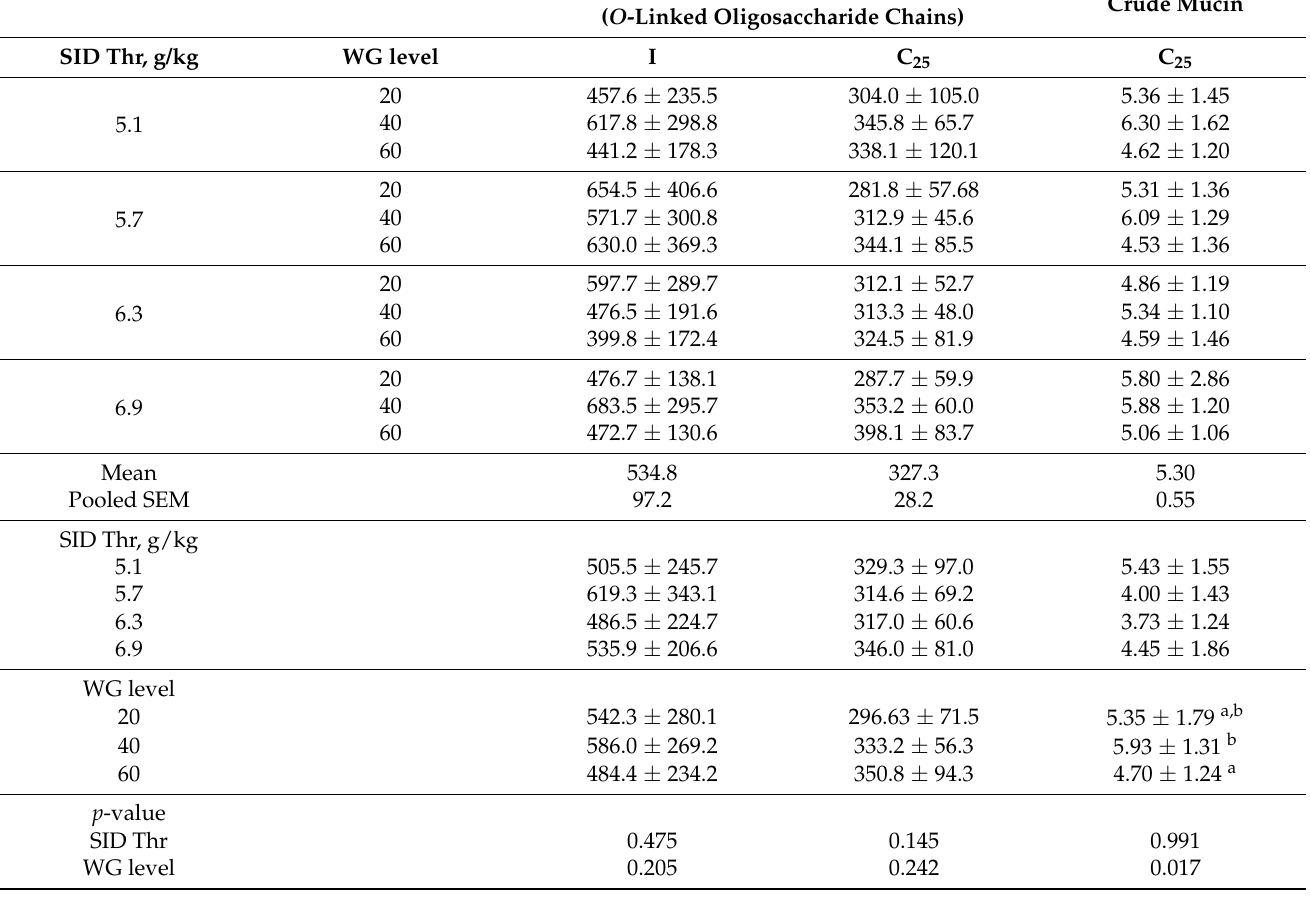
Table 2. Luminal mucin content measured as total amount of O -linked oligosaccharide chains ( µ g/g digesta) and luminal crude mucin content (%) in the ileum and proximal colon of pigs fed diets differing in standardized ileal digestible threonine (SID Thr) content and wheat gluten (WG) level. Mucin ( O -Linked Oligosaccharide Chains)